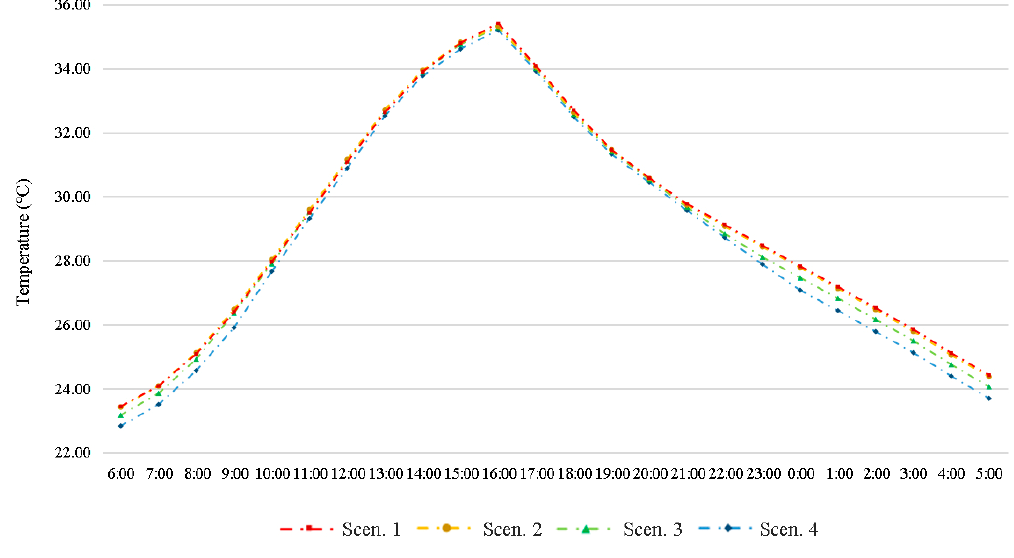
Figure 6. Cooling performance on air temperature of the four scenarios.